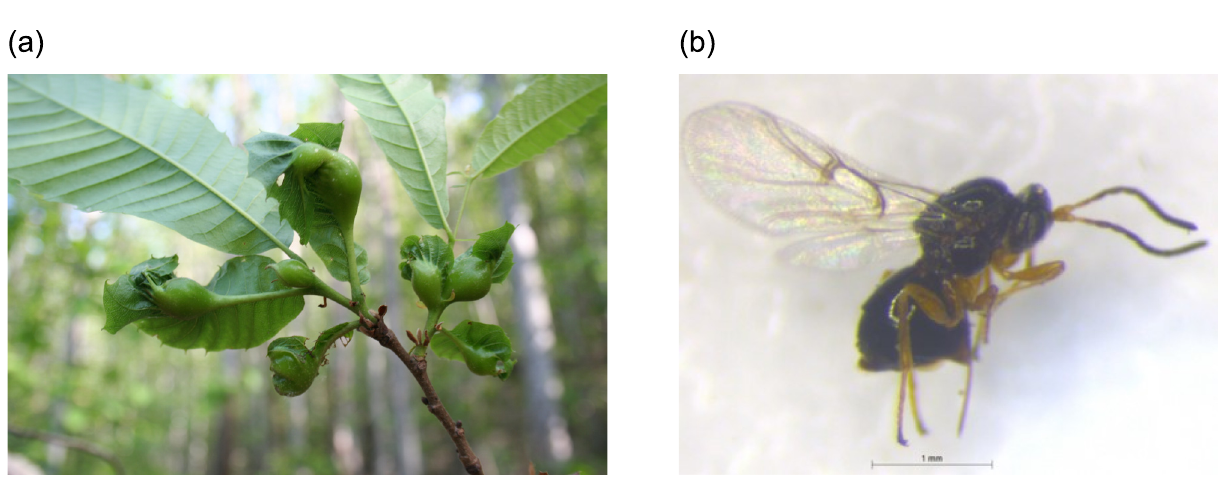
Fig 1. Galls induced by Dryocosmus kuriphilus (a) and Dryocosmu kuriphilus adult (b).